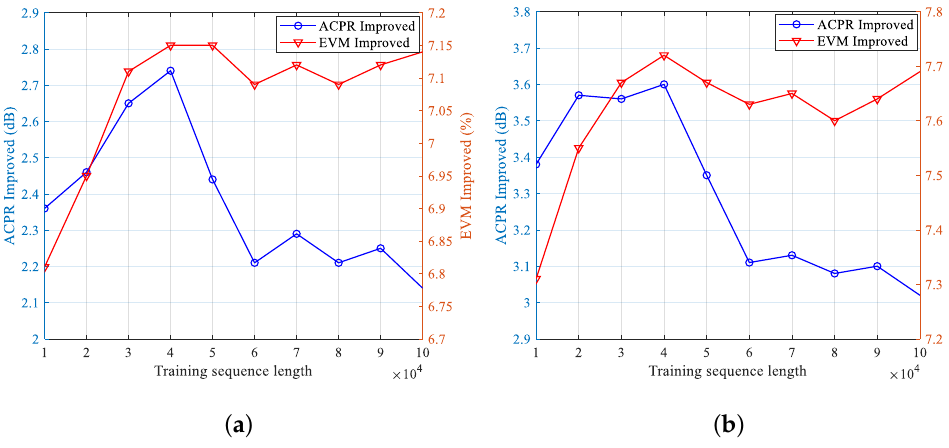
Figure 9. Improvement results of ACPR and EVM for different input power levels from VSG: ( a ) P in : − 25 dBm; ( b ) P − 24 dBm. in :